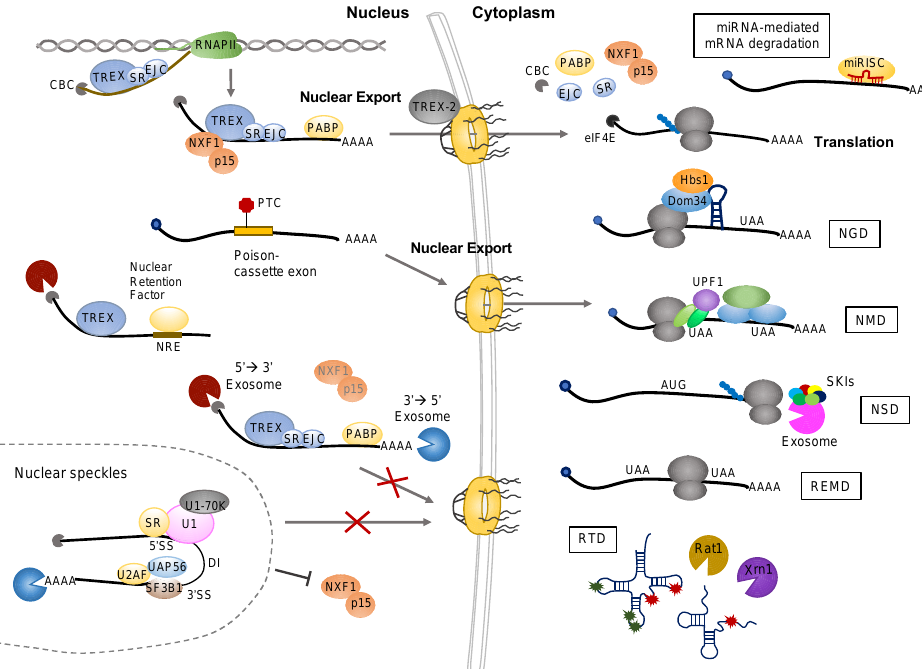
Figure 1. Molecular mechanisms of RNA QC. In eukaryotic cells, RNA biogenesis has multiple se- ries of processes, involving transcription, 5′ capping, splicing, polyadenylation, and export to cyto- plasm, and translation. During these processes, defective RNAs are subjected to RNA QC in the nucleus and cytoplasm. In nucleus, mRNAs with ‘detained’ introns are degraded by nuclear exo- somes in the nuclear basket. mRNAs, which interacts with retention factors or lacks export factors, are retained in the nucleus and finally degraded by nuclear exosomes. ‘Poison - cassette” exon -con- tained mRNAs, which have PTC in their exon, are exported to the cytoplasm and degraded by NMD pathway. In cytoplasm, abnormal RNAs can be distinguished from normal RNAs by RNA structure and binding proteins, and are directly degraded by several degradation pathways. mRNAs with PTC or long 3′UTR are degraded by NMD. In a proces s of NGD, mRNAs with translation elongation stalled structure are degraded by recruiting Dom34 – Hbs1 complex. NSD degrades mRNAs having no stop codon, and REMD destabilized mRNA in a poly(A)-dependent manner. In a process of RTD, tRNAs lacking several body modifications are degraded by 5′ - 3′ exonuclease, Rat1 and Xrn1.